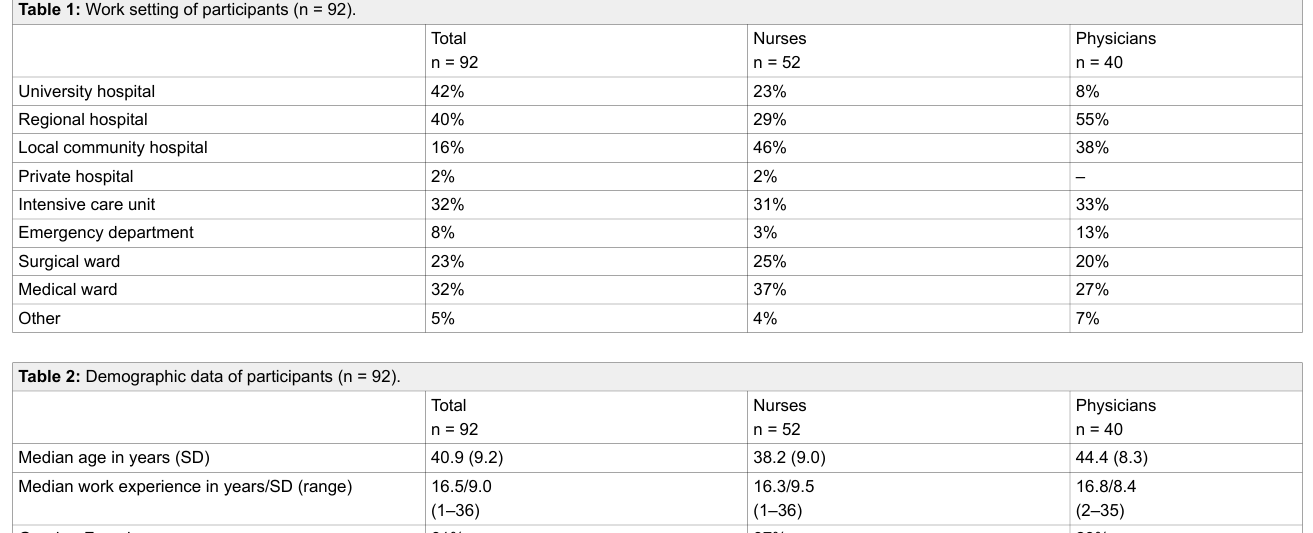
Table 2: Demographic data of participants (n =